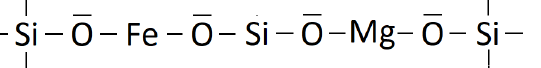
Figure 12. Cation bridge of Fe 2+ , Mg 2+ , and tetrahedra SiO 4 4+ in fayalite slag.